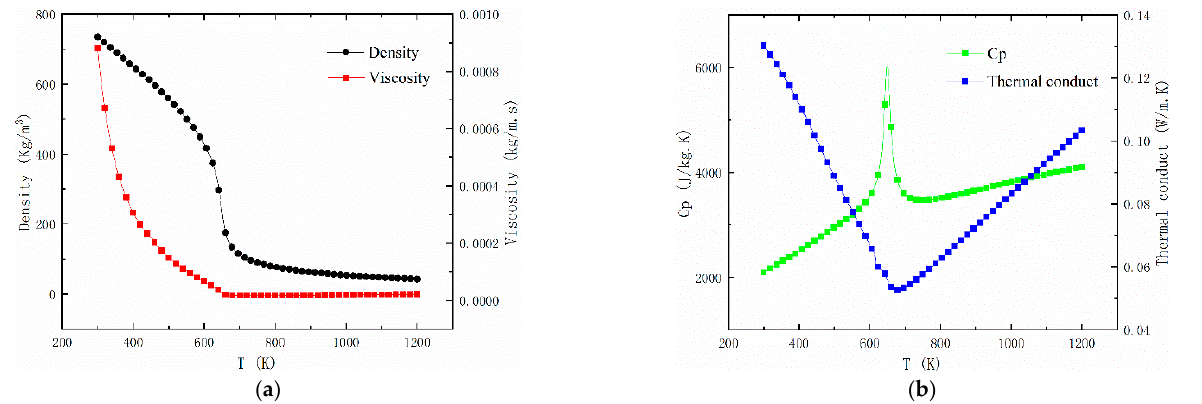
Figure 4. Thermophysical data of n-decane at 3 MPa calculated with SUPERTRAPP software. ( a ) density and viscosity; ( b ) Cp and thermal conductivity.